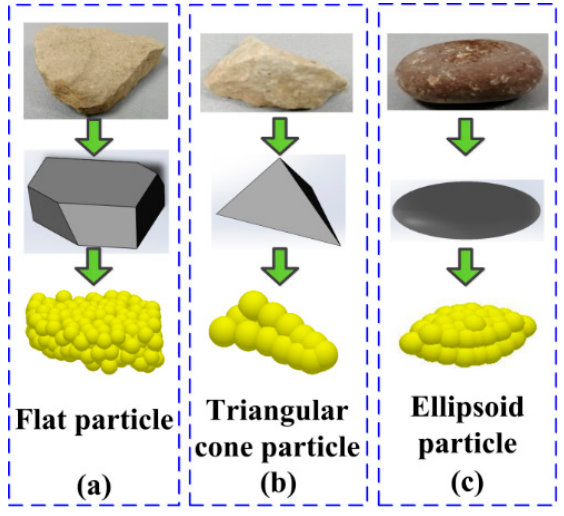
Figure 2. Discrete element model of wet sand and gravel particles with different shapes: ( a ) flat particle, ( b ) triangular cone particle, and ( c ) ellipsoid particle.